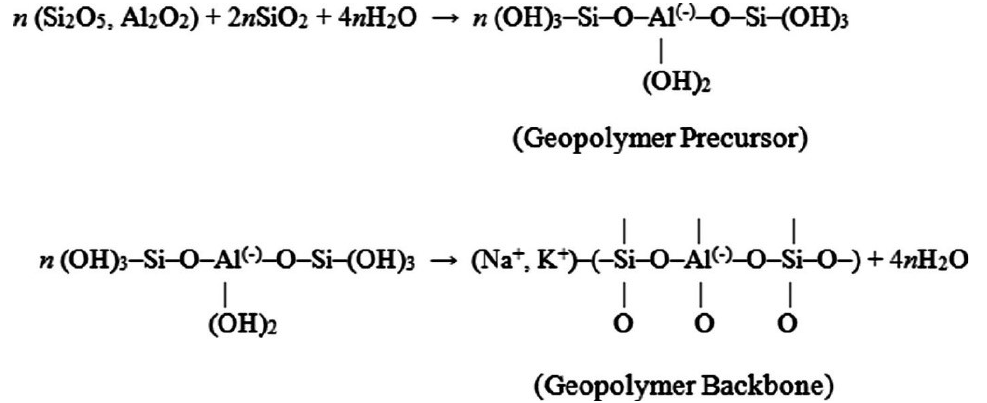
Figure 16. Geopolymerization reaction.